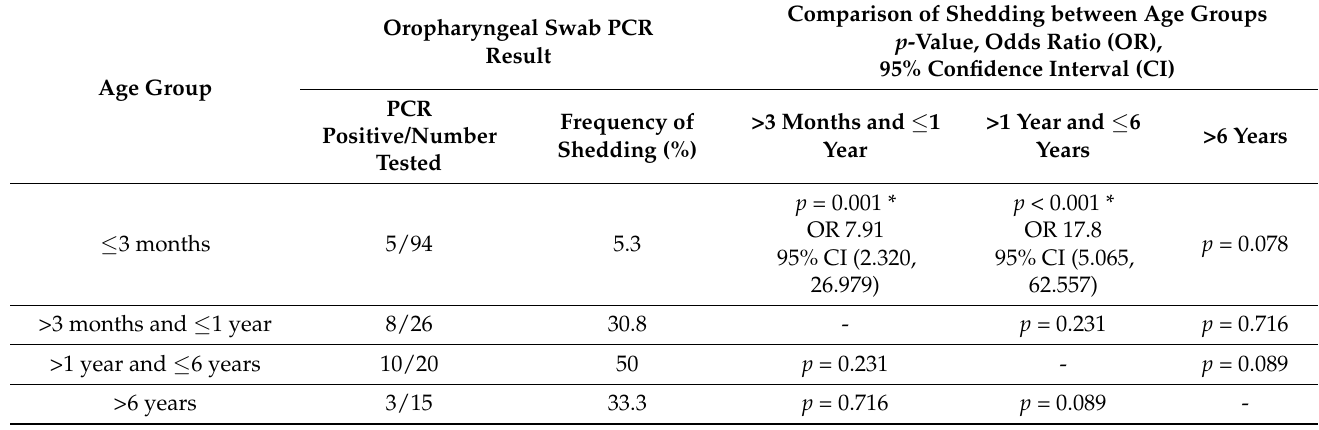
Table 1. Oropharyngeal shedding of FcaGHV1 DNA by cats in different age groups.